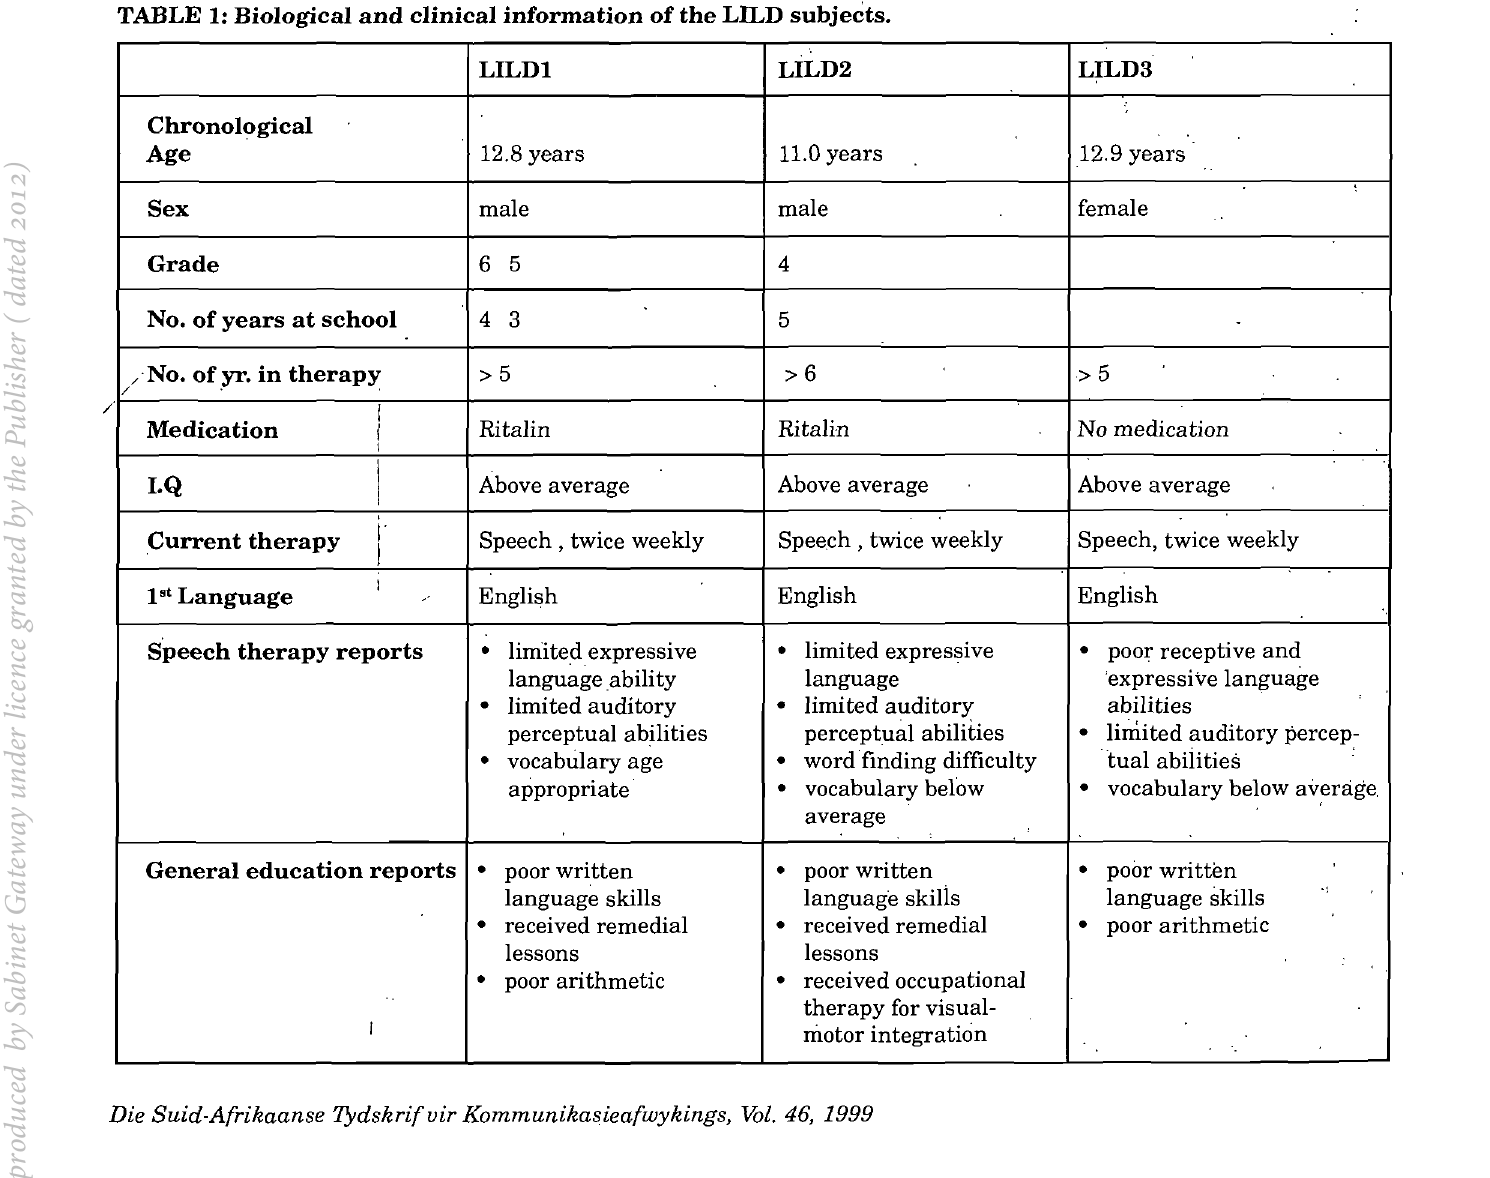
TABLE 1: Biological and clinical information of the LlLD